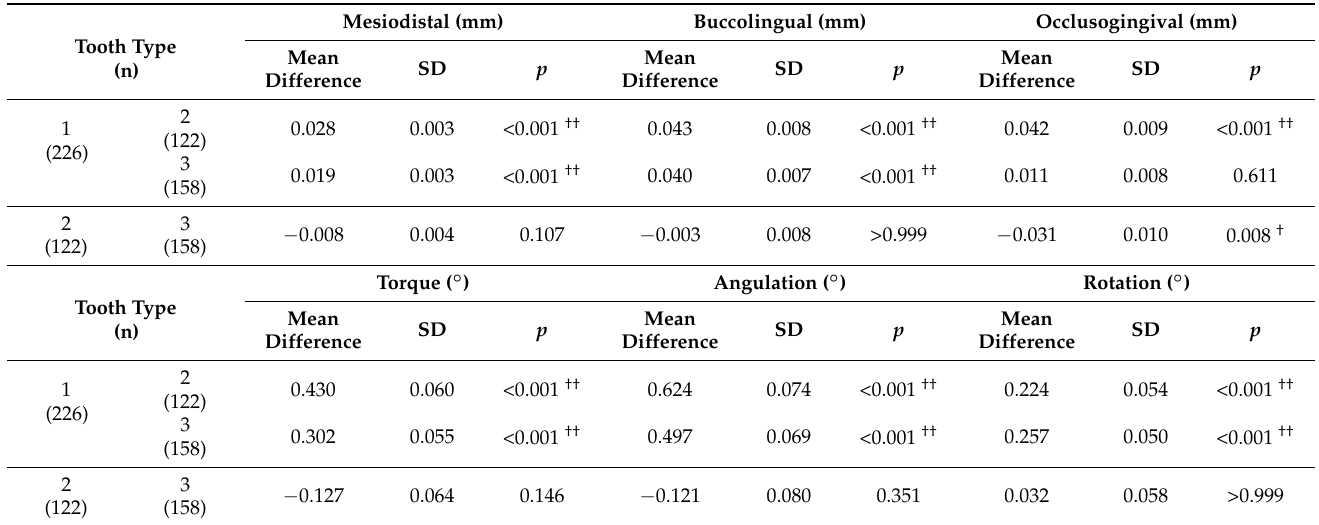
Table 4. Mutual comparison between six anterior teeth, premolars, and molars (group